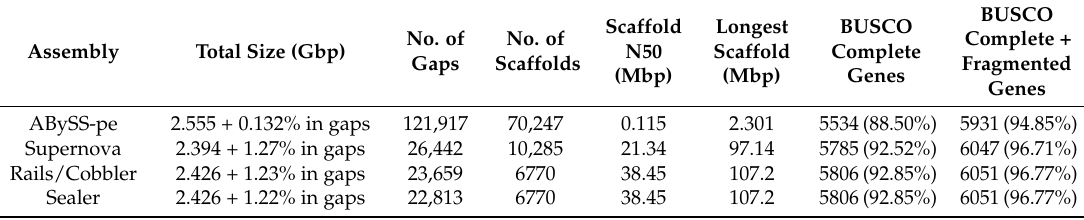
Table 1. Assembly statistics and gene content for the genome sequences reported in this